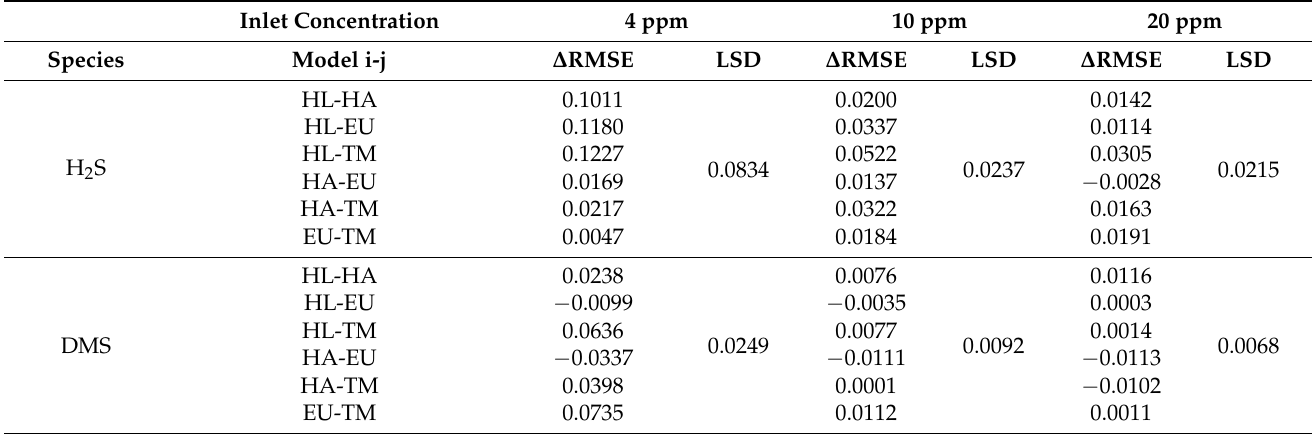
Table 6. Mean Square Error Root Difference ( ∆ RMSE) and Least Significant Difference (LSD) for each model and compound at different